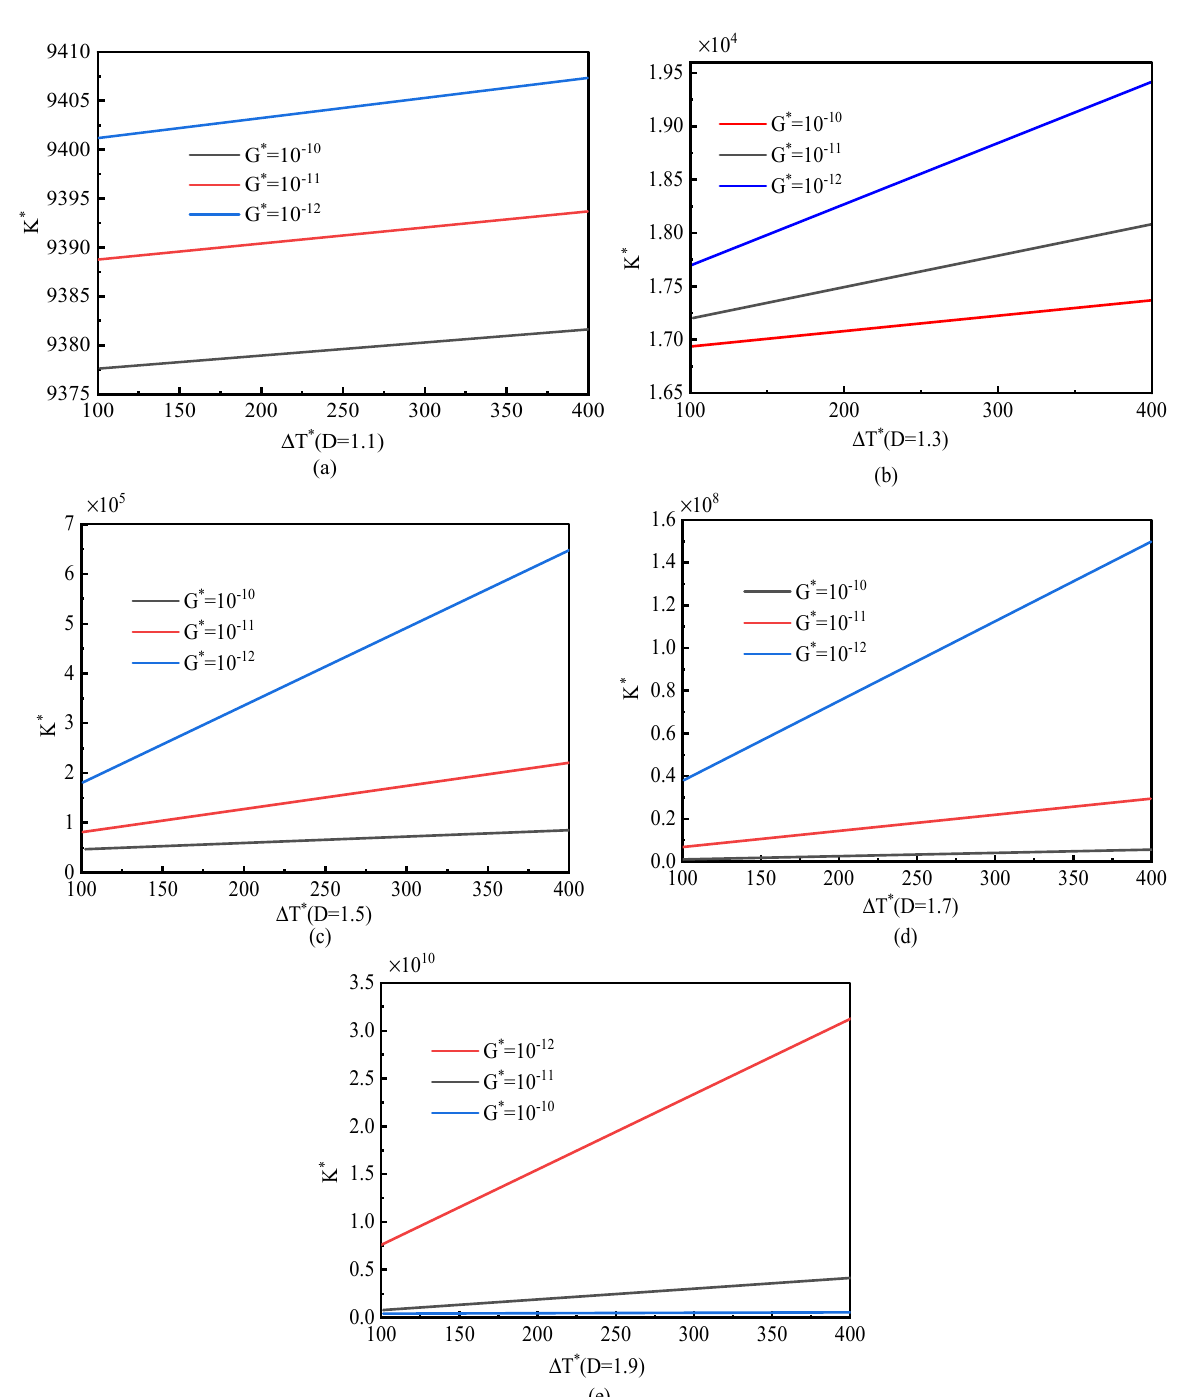
Figure 6 is the influence curve of fractal dimension D on normal contact stiffness K* when ∆ T ∗ = 300, G = 10 − 12 . As shown in the figure, within a specific range of contact force (1.1 (cid:54) D (cid:54) 1.5), the curve shows a nonlinear solid relationship. When D ≥ 1.6, the linear interface relationship is apparent, which is consistent with the corresponding relationship in Figure 5. The nonlinear interface relationship is again verified.